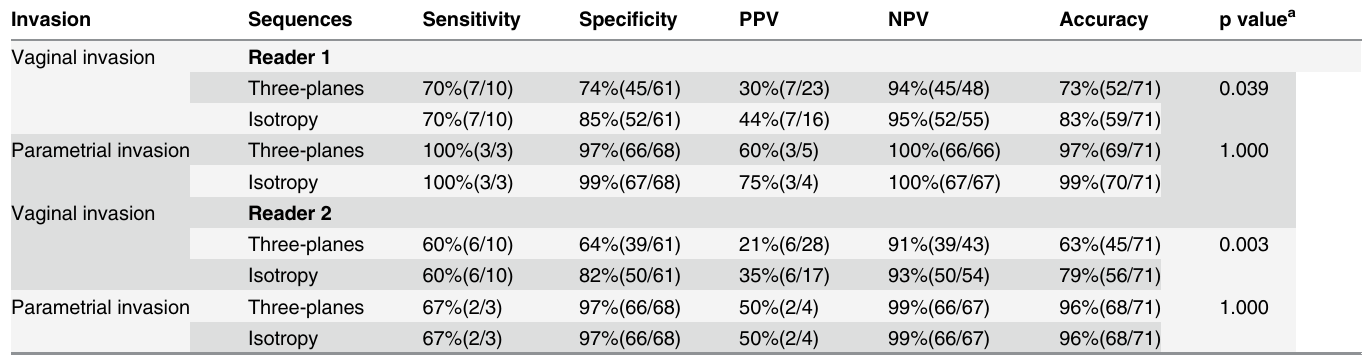
Table 7. Local tumor staging using the directly acquired sequence vs. 3D isotropic